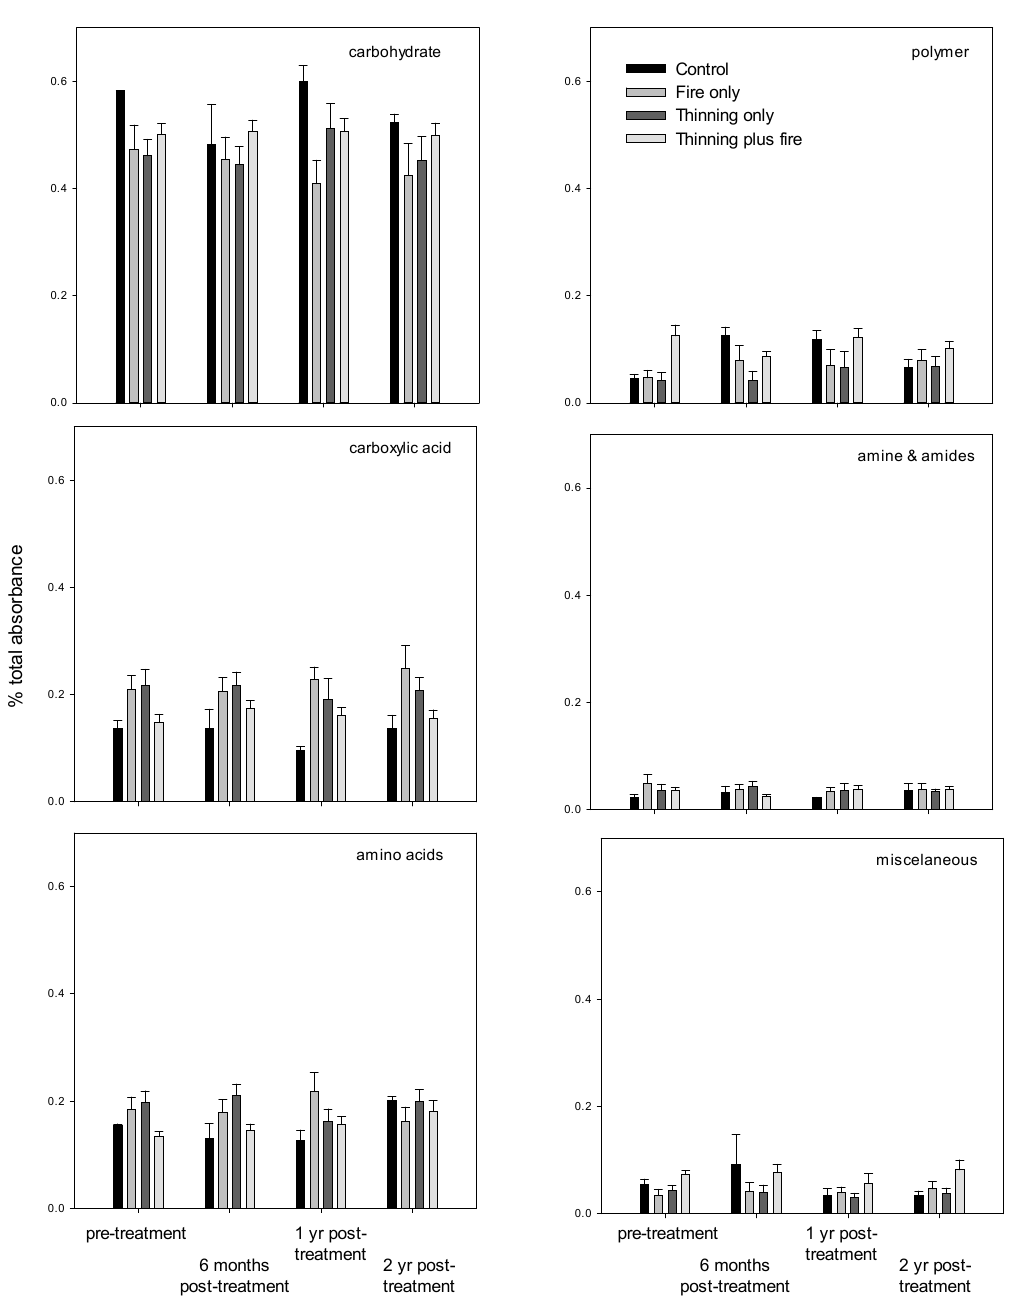
Figure 5. Community-level physiological profiles for fungi (Biolog™ SFN2) in surface mineral soil (0–5 cm) 1-year post-treatment at the Southwestern Plateau, Fire and Fire Surrogate study site. Data shown are observed mean catabolic activity + SE ( n = 3) by substrate guild, normalized to the total catabolic activity in that treatment. No significant differences ( α = 0.05) were found among treatments based on a multi-response permutation procedure.